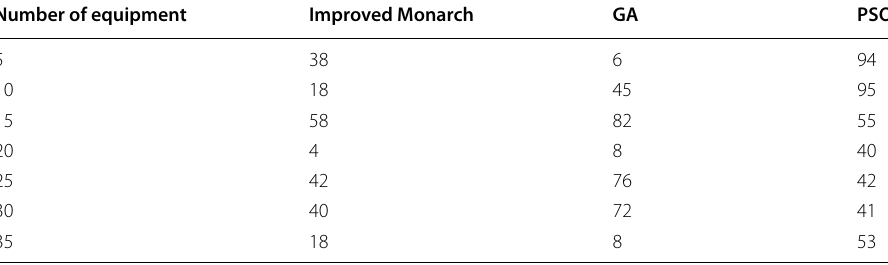
Table 1 Convergence times of the three algorithms when recognizing user changes Number of equipment